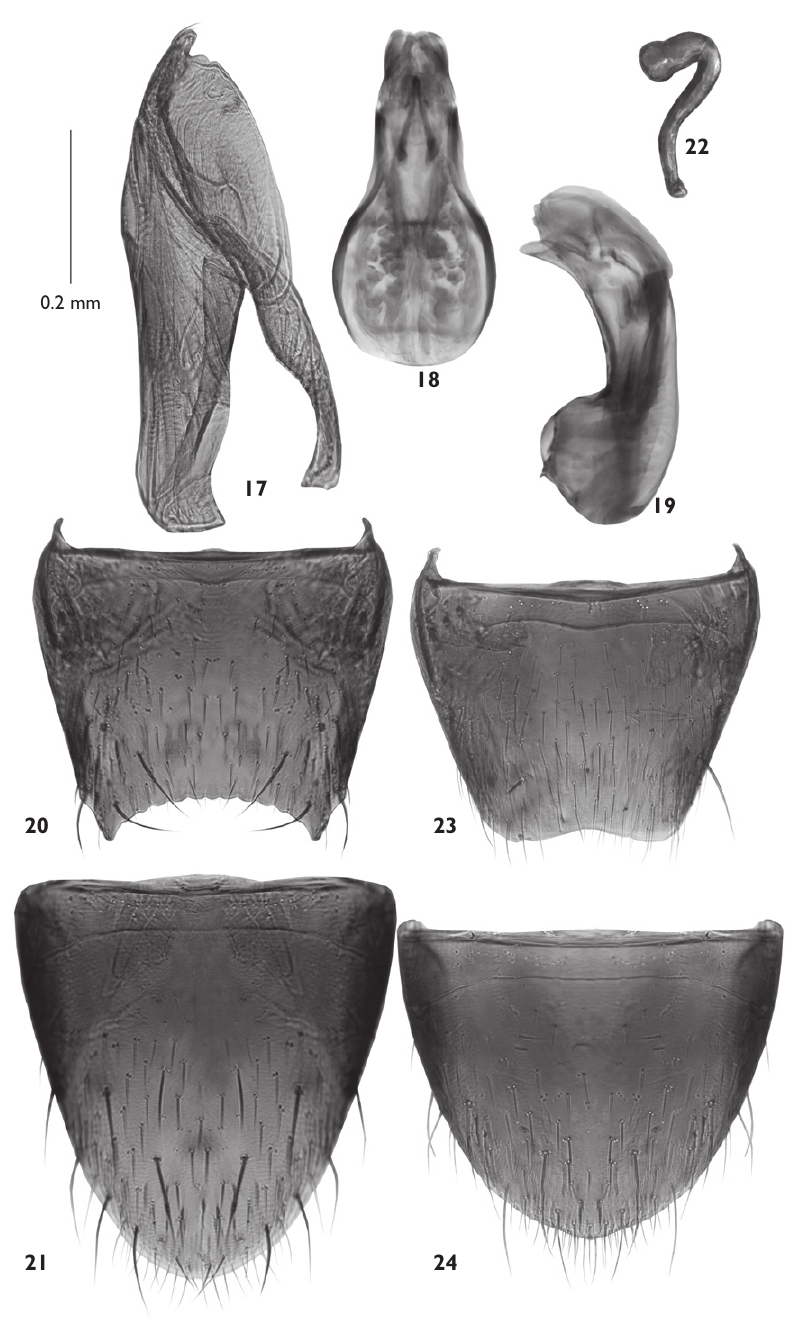
Figures 17–24. Schistoglossa campbelli : 17 paramere 18 median lobe of aedeagus in dorsal view 19 median lobe of aedeagus in lateral view 20 male tergite 8 21 male sternite 8 22 spermatheca 23 female tergite 8 24 female sternite